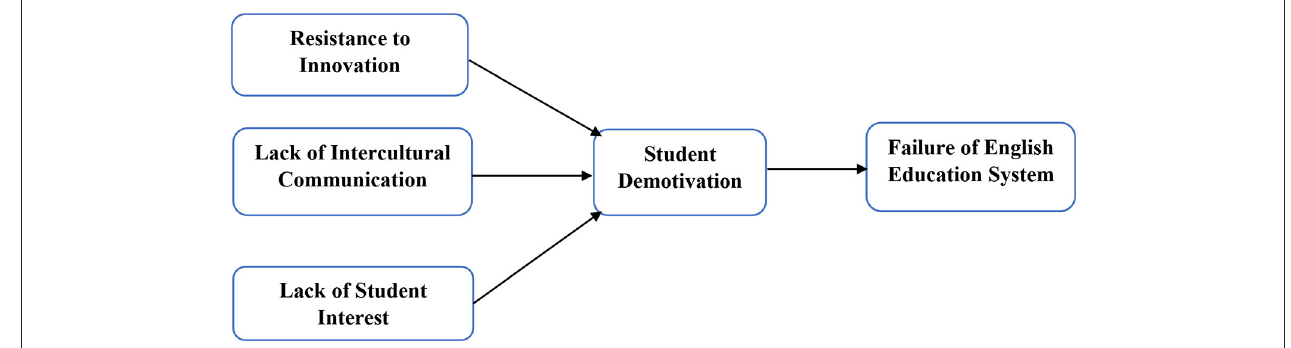
FIGURE 2 | Theoretical framework.